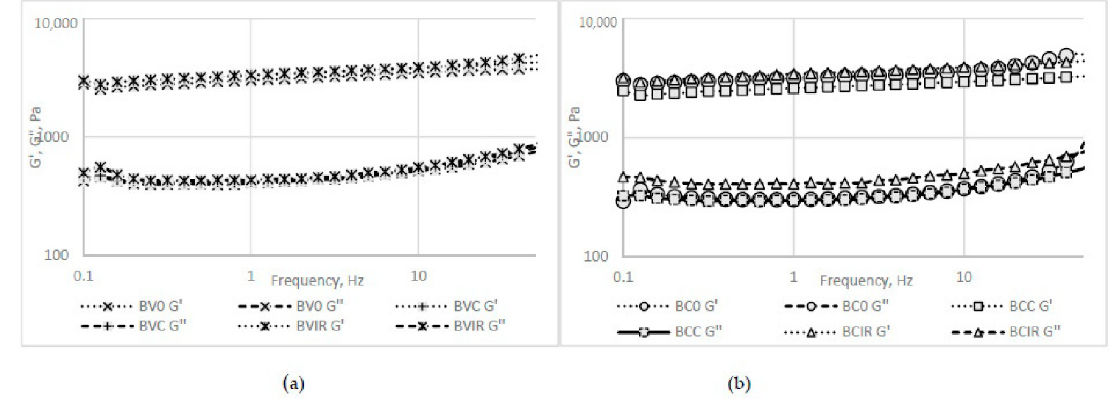
Figure 5. Rheological behavior as revealed by the frequency sweep test: ( a ) Beta vulgaris L. var. vulgaris , ( b ) Beta vulgaris L. var. cylindra .